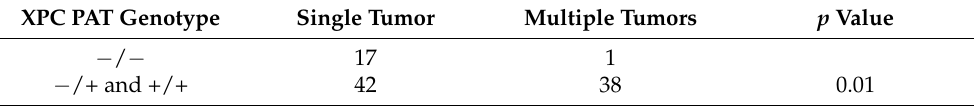
Table 3. Association of XPC PAT − /+ SNP with the number of bladder tumors per patient. XPC PAT